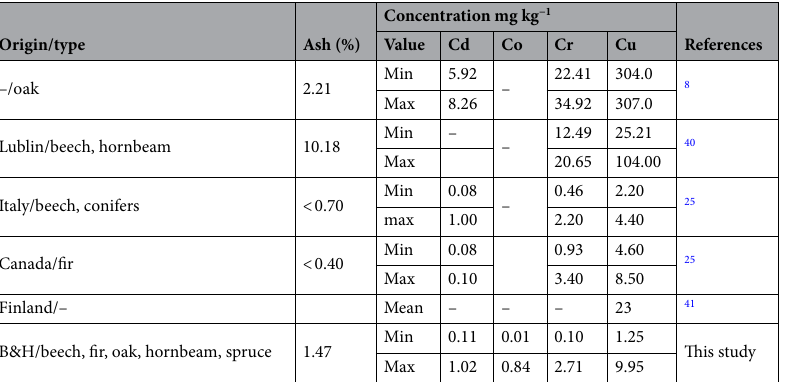
Table 4. Comparison of obtained values of heavy metals (Cd, Co, Cr, and Cu) in analyzed wood pellets with similar studies.